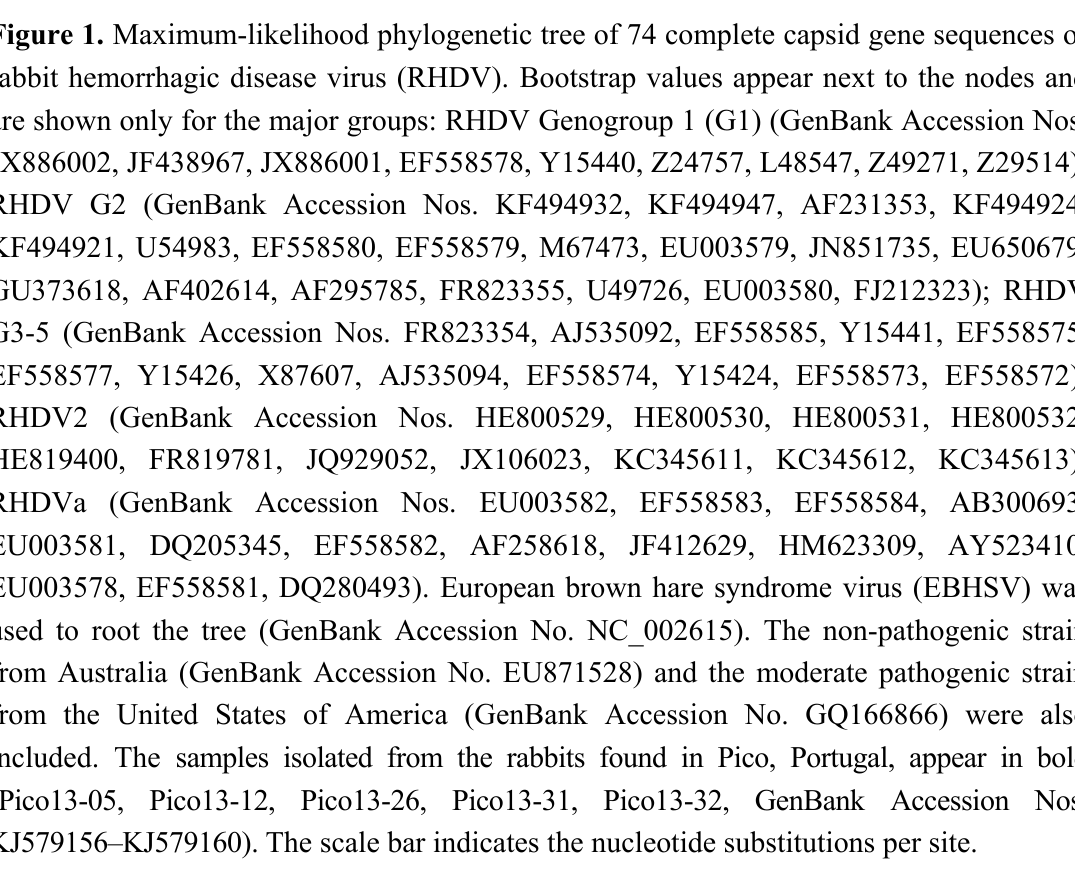
Figure 1. Maximum-likelihood phylogenetic tree of 74 complete capsid gene sequences of rabbit hemorrhagic disease virus (RHDV). Bootstrap values appear next to the nodes and are shown only for the major groups: RHDV Genogroup 1 (G1) (GenBank Accession